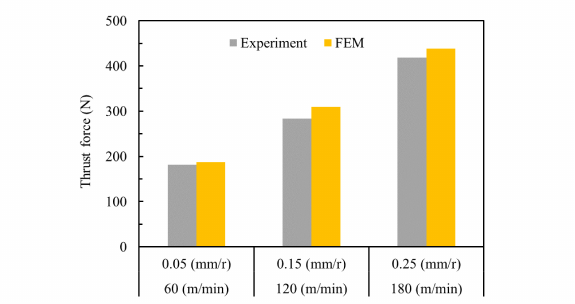
Fig. 4. Experimental and prediction results of thrust